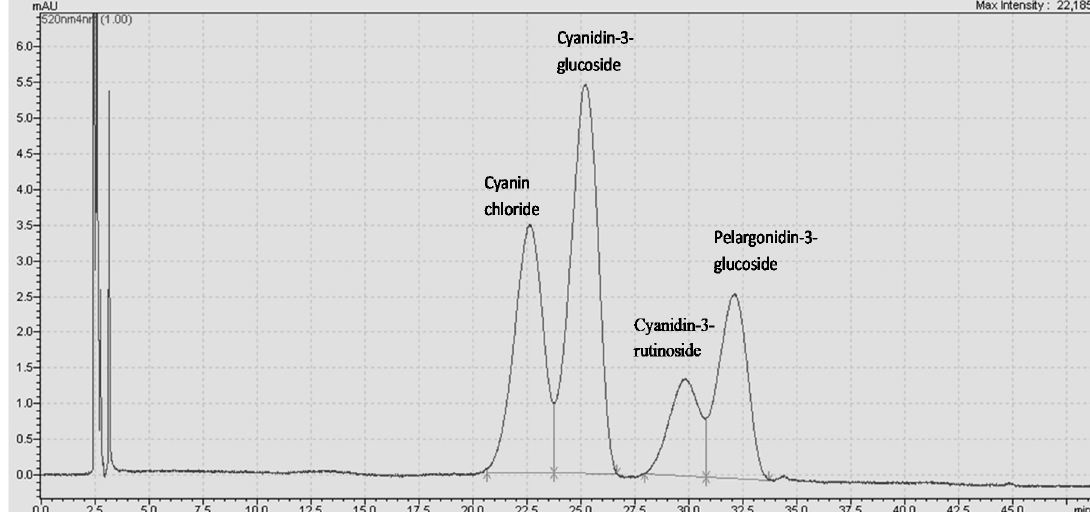
Figure 5. HPLC chromatogram of individual anthocyanins obtained fron borage flowers under optimal conditions.